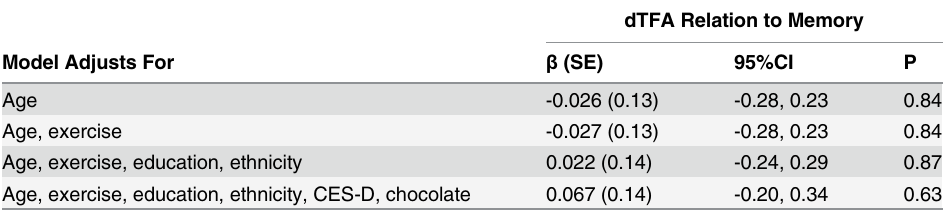
Table 3. Dietary Trans Fat Relation to Memory, Stratified by Age: Men Age (cid:1) 45. dTFA Relation to Memory Model Adjusts For β (SE) 95%CI P Age -0.026 (0.13) -0.28, 0.23 0.84 Age, exercise -0.027 (0.13) -0.28, 0.23 0.84 Age, exercise, education, ethnicity 0.022 (0.14) -0.24, 0.29 0.87 Age, exercise, education, ethnicity, CES-D, chocolate 0.067 (0.14) -0.20, 0.34 0.63 dTFA = dietary trans fatty acid; β = regression coef fi cient; SE = standard error; CI = con fi dence interval; CES-D = Center for Epidemiological Studies Depression Scale. Results of linear regression of dTFA on recurrent word score, with adjustments as per Table. Retaining women in the analysis (N = 315 women were age (cid:1) 45) does not materially alter the fi ndings: for the fully